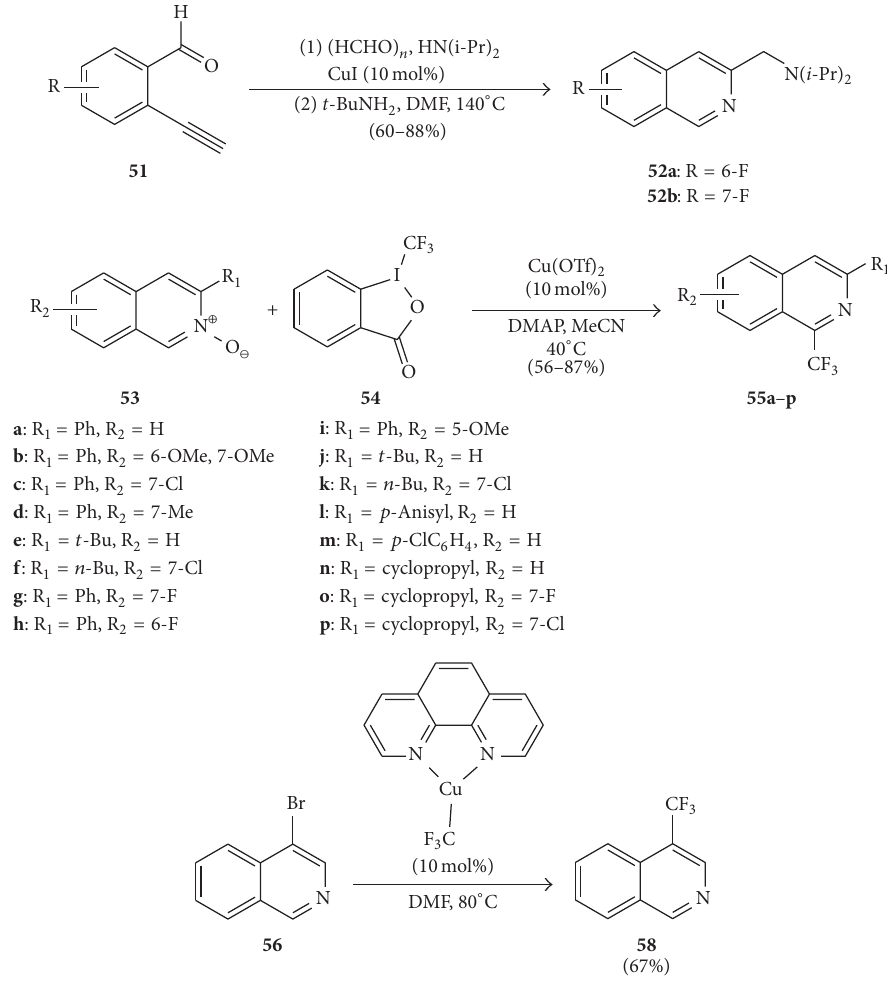
Scheme 14: Copper catalyzed fluoroisoquinoline